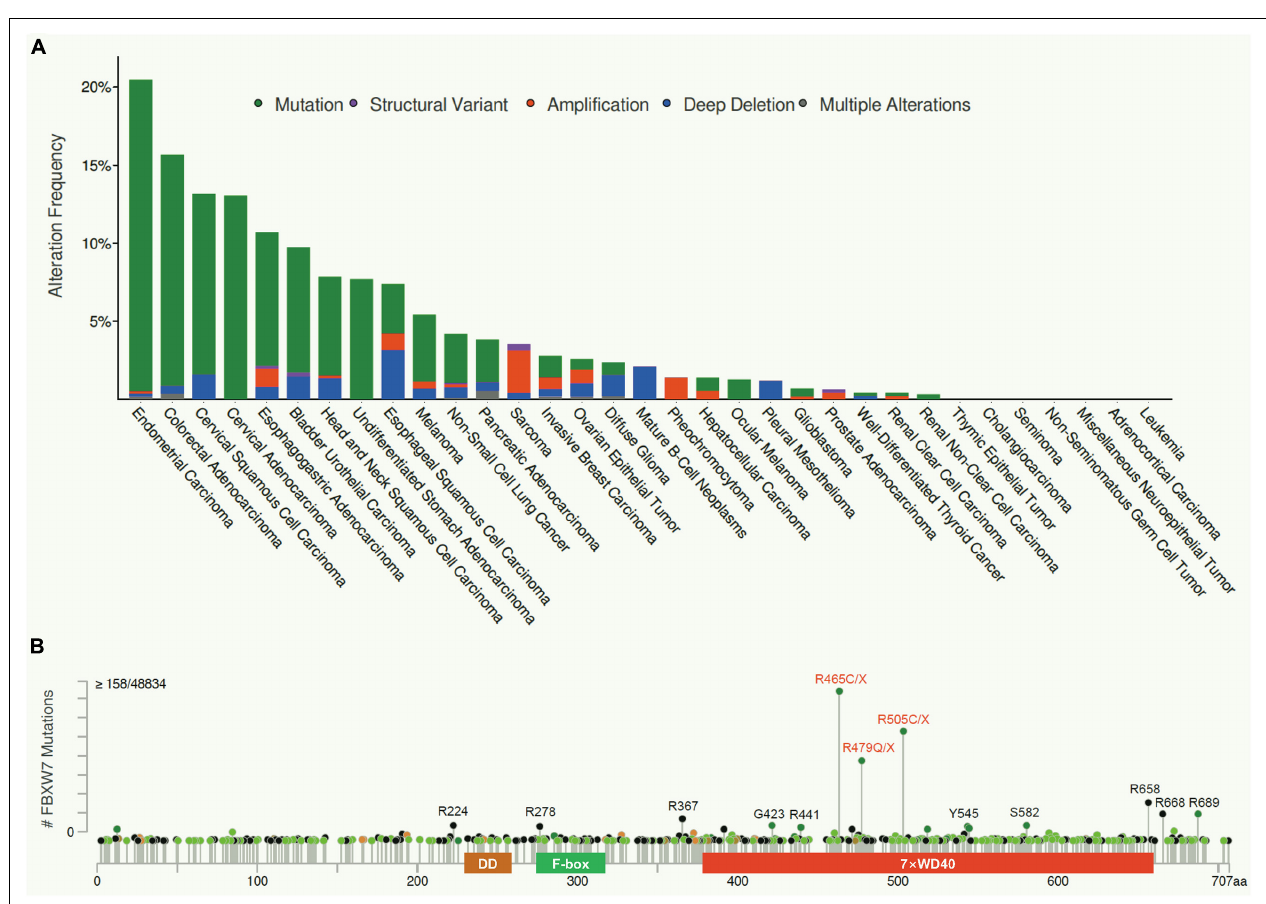
FIGURE 2 | FBXW7 mutation frequency in human cancers and their distributions. (A) FBXW7 mutation frequency in different types of human cancer, analyzed from cBioPortal Database (https://www.cbioportal.org/). (B) Distribution of FBXW7 mutations in the FBXW7 encoding region. Mutations detected in more than 15 cancer samples are annotated, and three most frequent mutation hotspots, R465, R479, and R505 are highlighted in red.